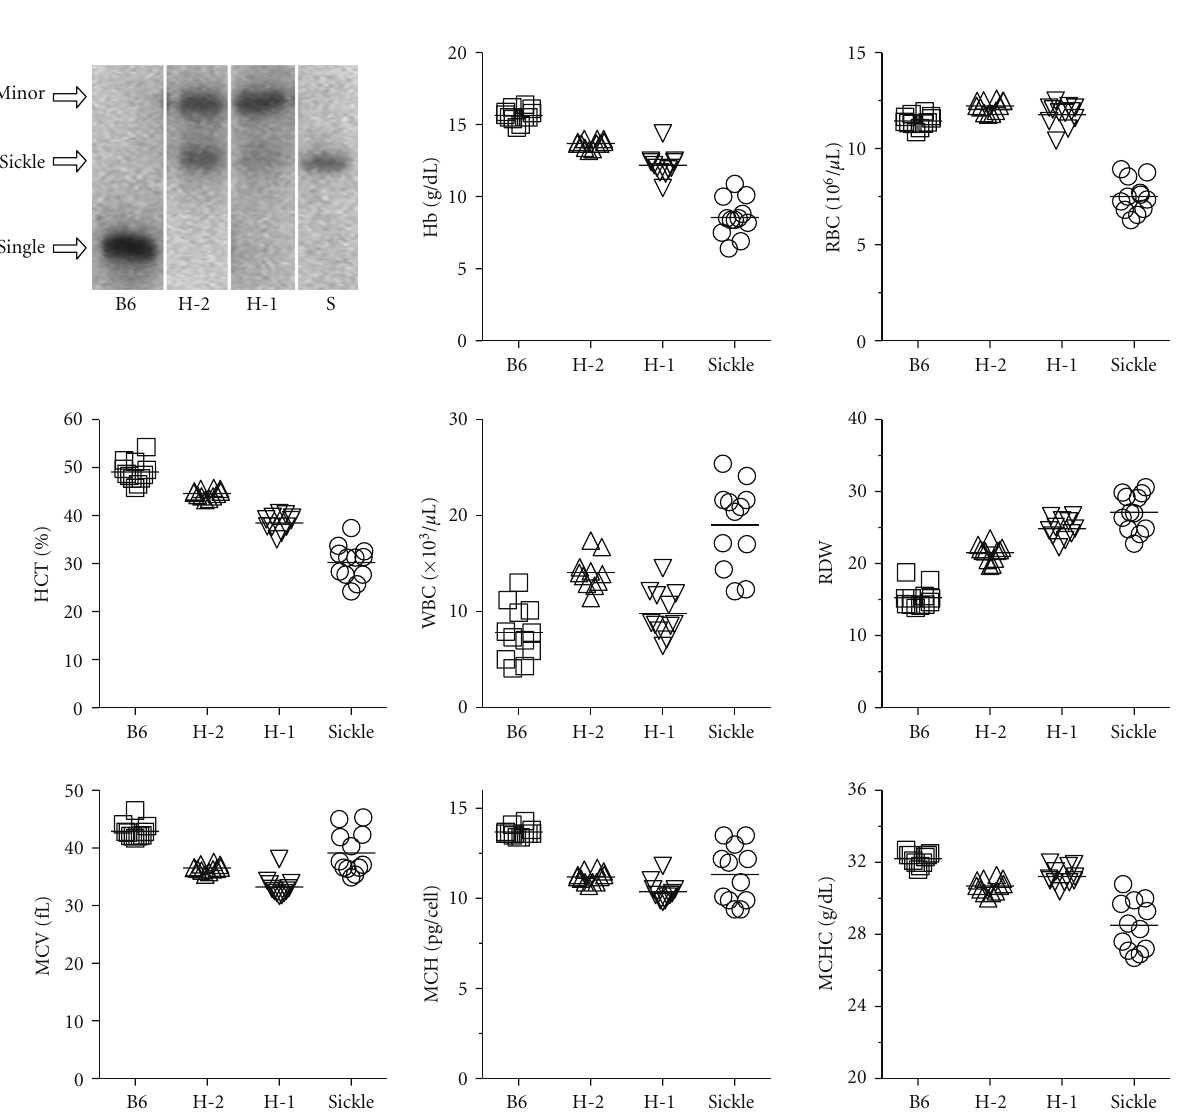
Figure 1: Hemoglobin and hematology profile of Berkeley sickle mice. Hemoglobin electrophoresis of RBC from C57BL/6, H-2, H-1, and homozygous sickle mice. C57BL/6 mice show a “single” hemoglobin band, whereas the H-2 and H-1 hemizygotes show beta-sickle globin resulting from two or one copy of the transgene, respectively, in combination with the minor band of di ff use beta-globins. Homozygous sickle mice only have the characteristic band of beta-sickle globin. The complete blood counts of C57BL/6 mice, H-2, H-1, and homozygous sickle mice ( n = 10 per genotype) are also shown with the hemizygous mice having intermediate values between C57BL/6 mice and homozygous sickle